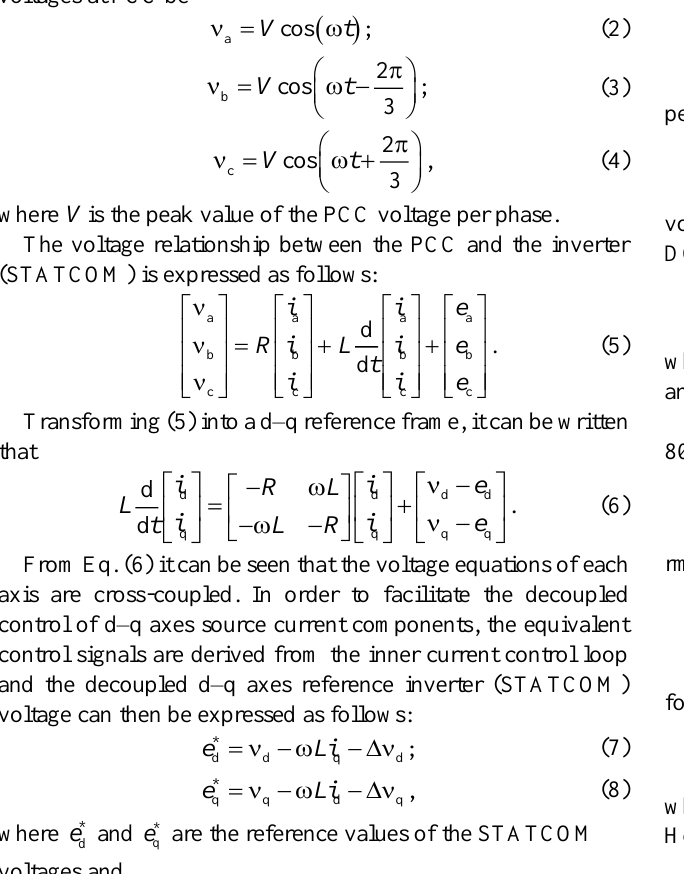
Fig. 2. Discrete PLL system for the detection of the phase angle and the frequency of the source (grid)